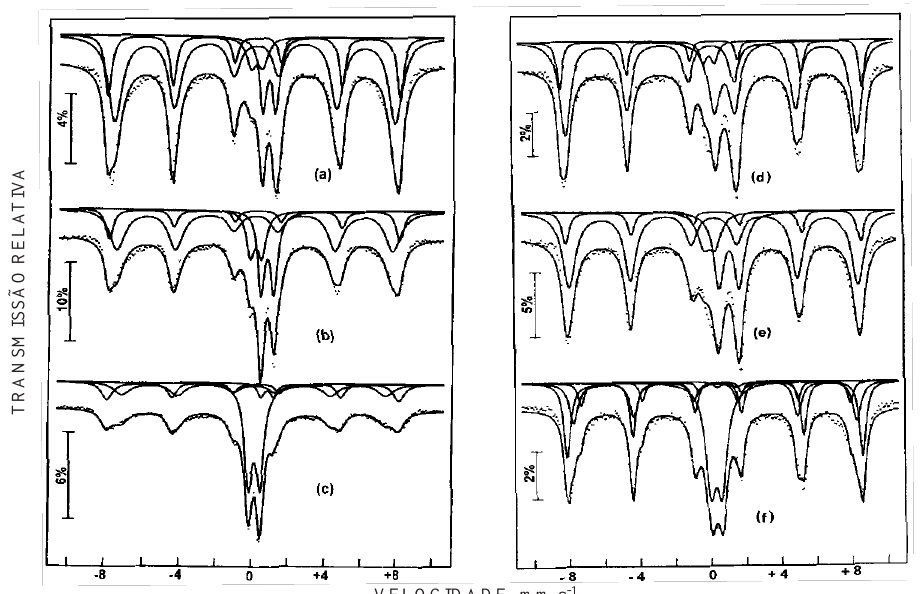
Figura 2. Espectros Mössbauer à temperatura do ambiente das frações (a) areia e (b) silte, após concentração magnética e tratamento com NaOH 5 mol L -1 , seguidas de 4xDCB, (c) argila, após tratamento com NaOH 5 mol L -1 e espectros correspondentes a 85 K, das frações (d) areia e (e) silte, após concentração magnética e tratamento com NaOH 5 mol L -1 , seguida de 4xDCB, (f) argila, após tratamento com NaOH 5 mol L -1